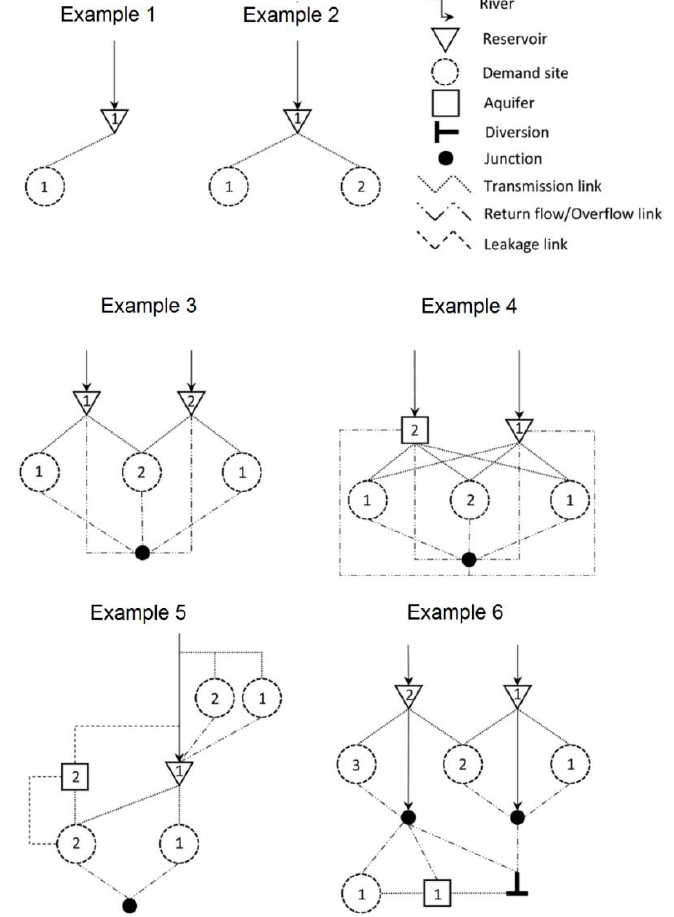
Figure 5. Conceptual water resources models implemented in R using WRSS . Object priorities are shown by values written over the objects (the smaller value the higher priority).